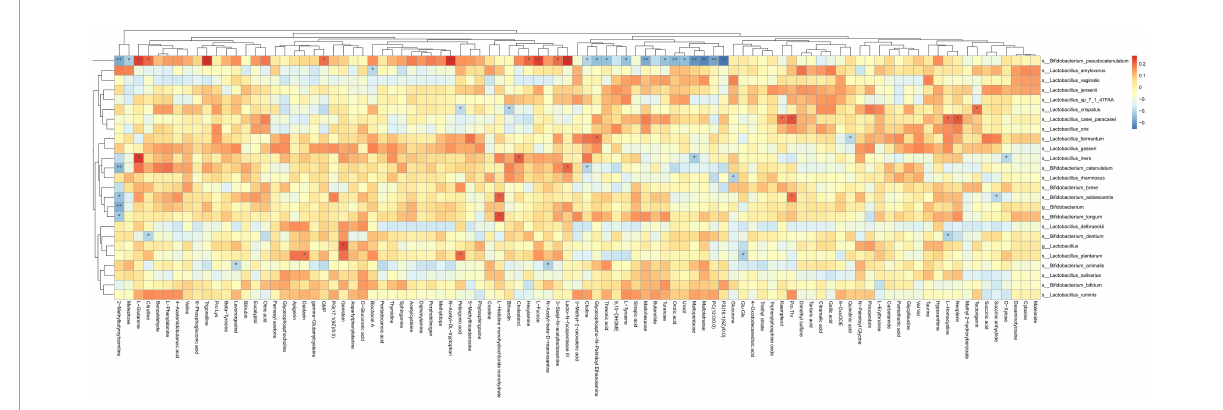
FIGURE6 Correlation analysis between changed metabolites and probiotic changes. Asterisks represent that the corresponding probiotics have a significant correlation with short-chain fatty acids. Red means positive correlation, and blue means negative correlation.